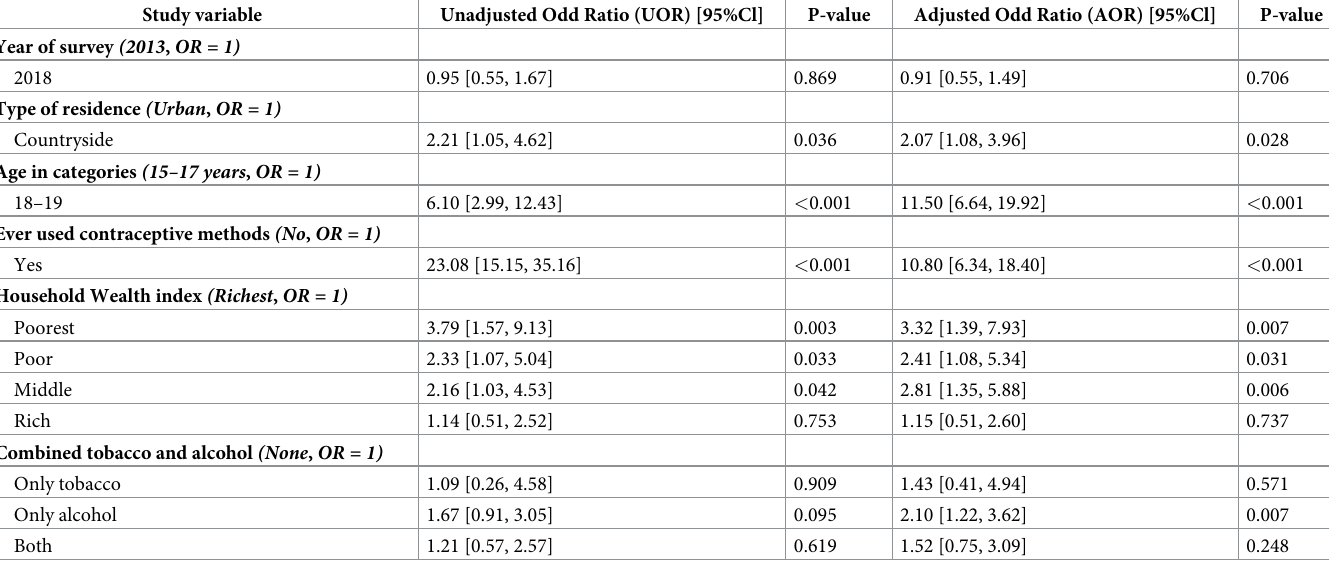
Table 3. Unadjusted and adjusted odds ratios (OR) with 95%CI for factors associated with adolescent pregnancy in Mongolia, MSISS 2013 and 2018 (N = 2794). Study